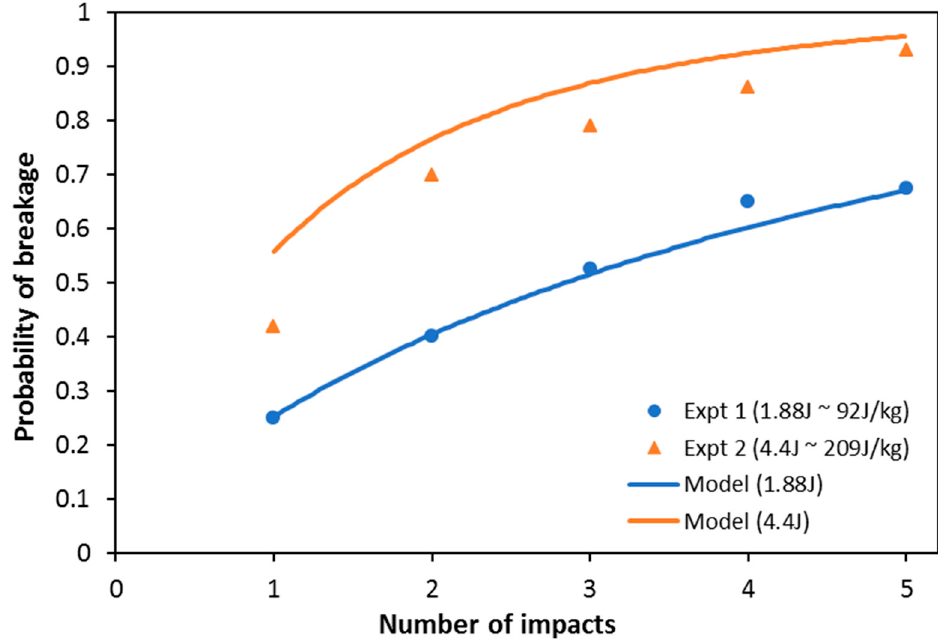
Figure 7. Comparison of experiment breakage probabilities with the model prediction for the − 26.5 +